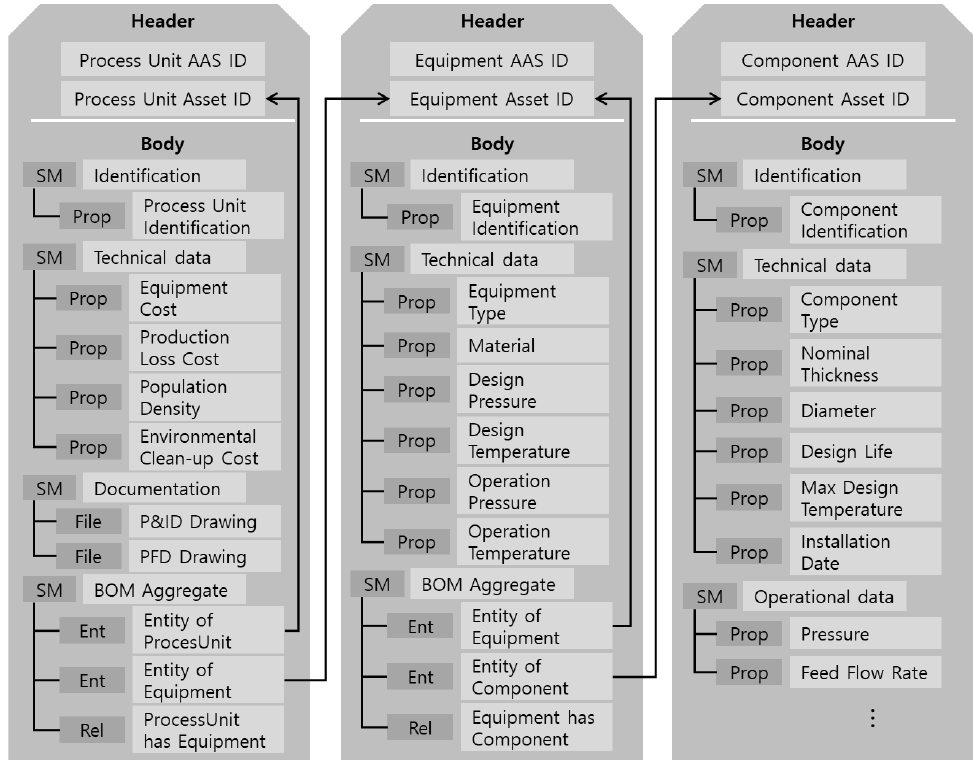
Figure 7. AAS- based neutral model for process plant’s maintenance data . Figure 7. AAS-based neutral model for process plant’s maintenance